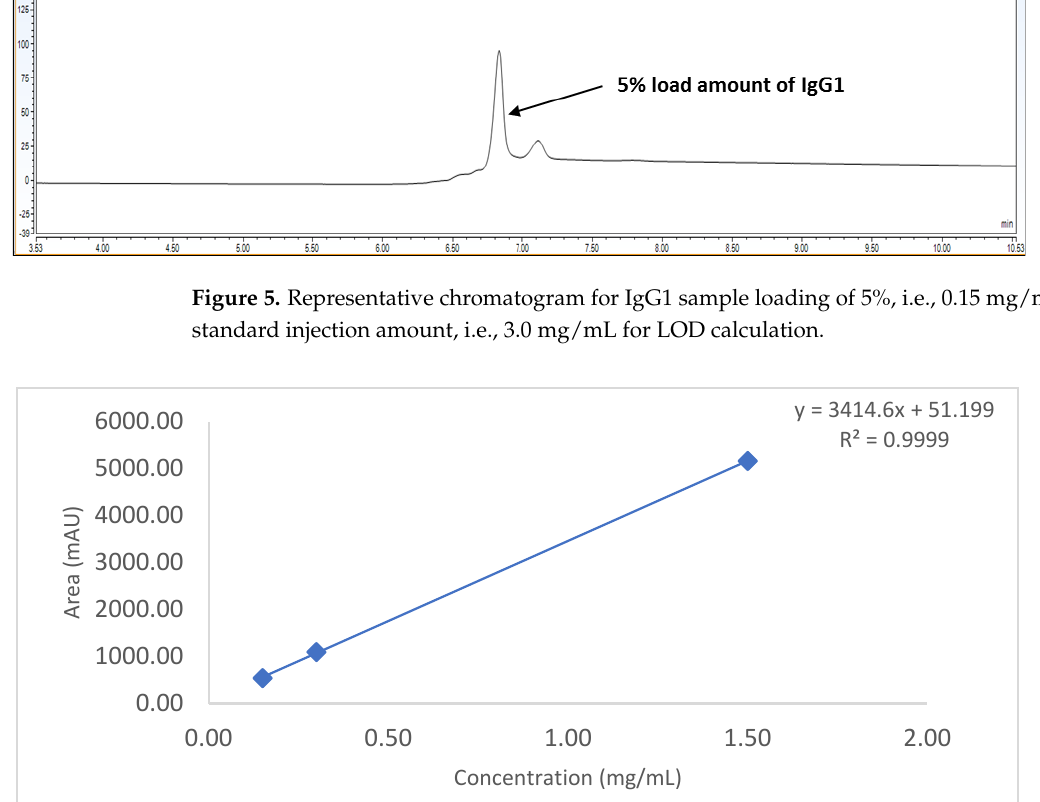
Figure 6. Slope and intercept calculation using loading amount (mg/mL) versus main peak area (mAU) obtained from 1.5 mg/mL to 0.15 mg/mL.